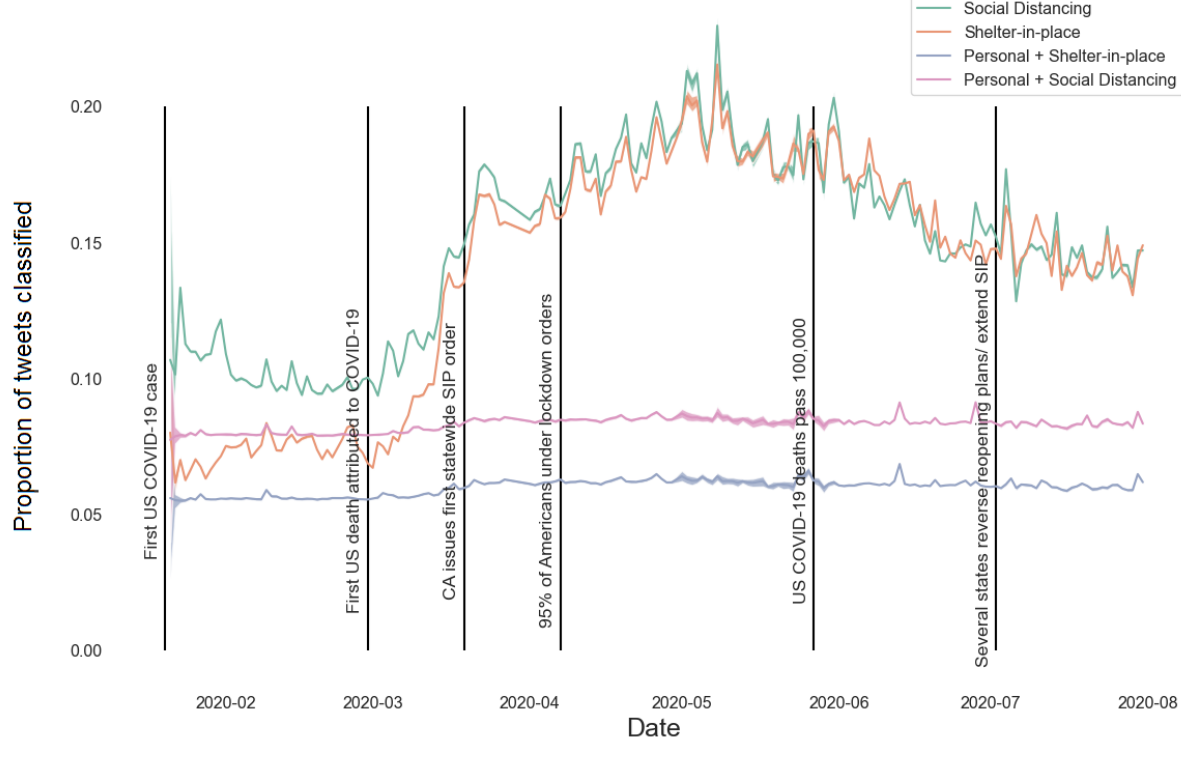
Random forestLogistic regressionClassifier